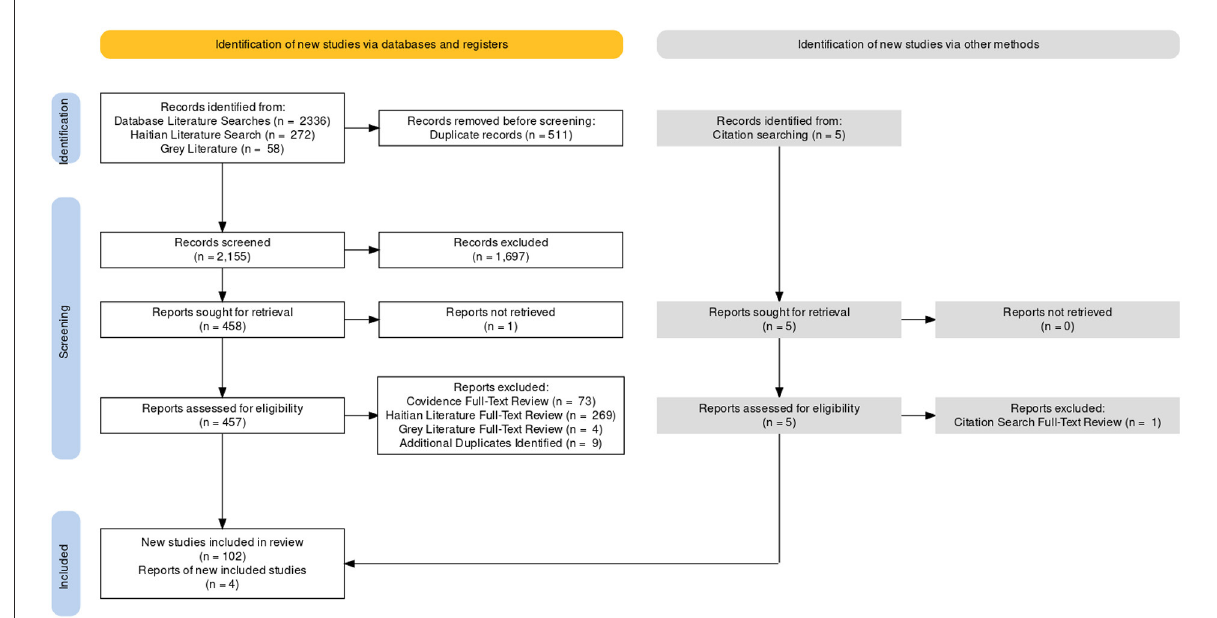
FIGURE1 Preferred reporting items for systematic reviews and meta-analyses (PRISMA) flow diagram. A total of 106 articles were included. This flow diagram was created, using Evidence Synthesis Hackathon software (https://www.eshackathon.org/, Evidence Synthesis